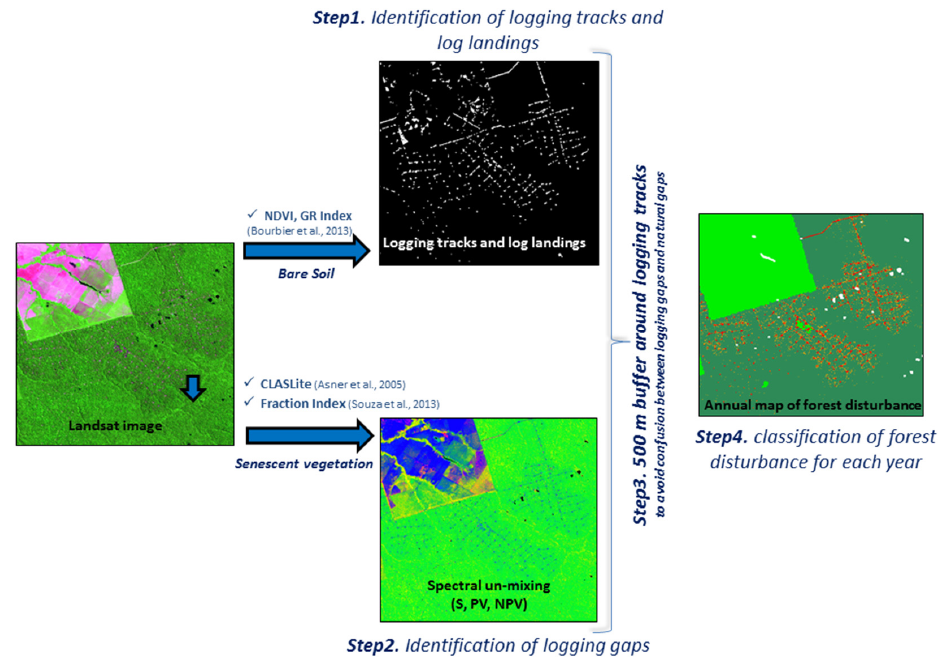
Figure 3. Remote sensing methodology to detect forest disturbance in terms of canopy openings. First, the logging tracks and log landings are identified using spectral indices to enhance bare soil. Second, logging gaps are identified using spectral un ‐ mixing and fraction indices to enhance senescent vegetation. Third, to avoid confusion between logging gaps and natural gaps, only gaps situated within a maximum distance of 500 m around logging tracks and log landings are considered as logging gaps. Finally, all these data are gathered to obtain a forest disturbance map of the study area for each year.